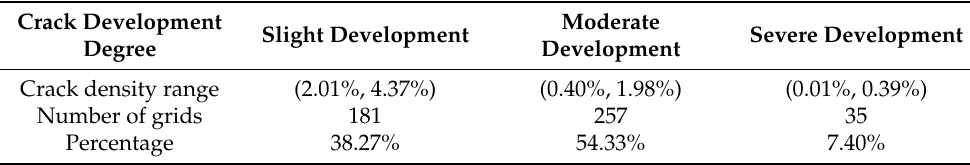
Figure 8. The results for soil moisture content measurements of loess and sandy soil at different distances from the crack. Table 6. Statistical results for the degree of crack development based on grids.